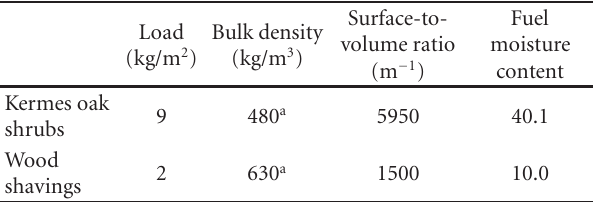
Table 1: Properties of the test fuel beds considered in this